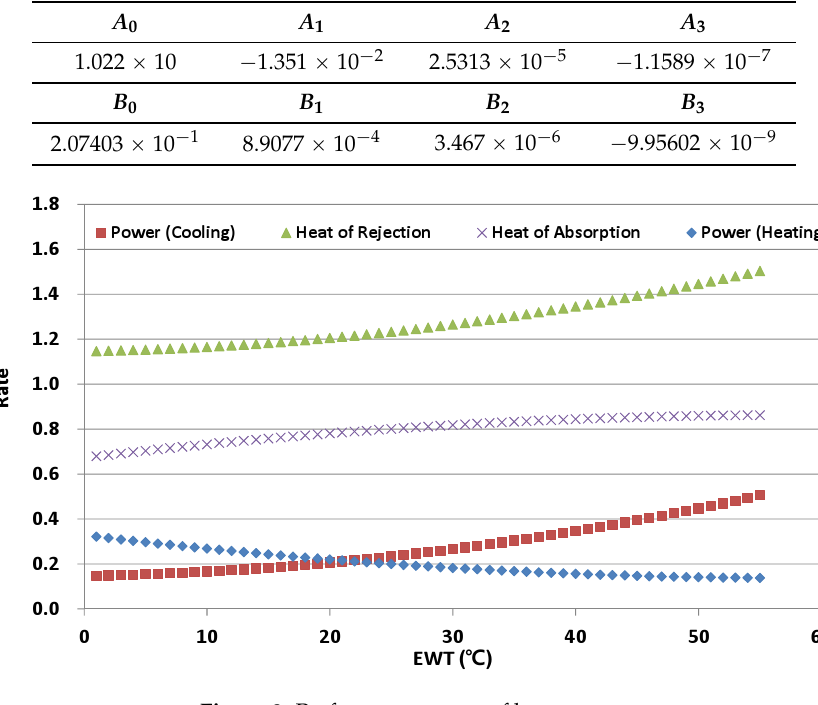
Figure 3. Performance curve of heat pump. Table 2. Heat pump model coefficients.